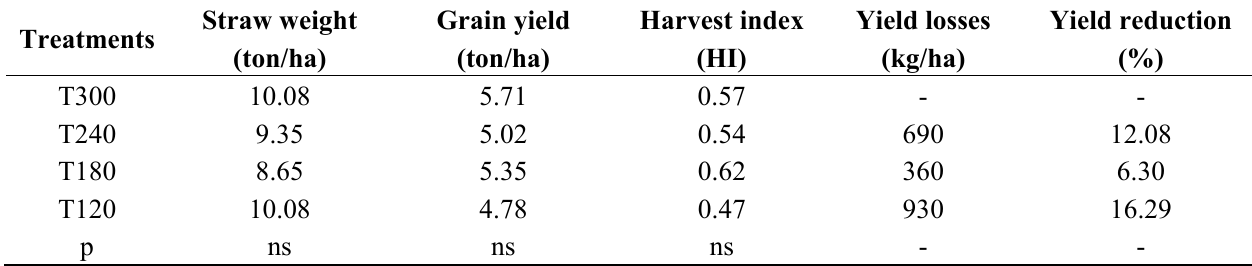
Table 4. Water treatments effects on yield and harvest index.